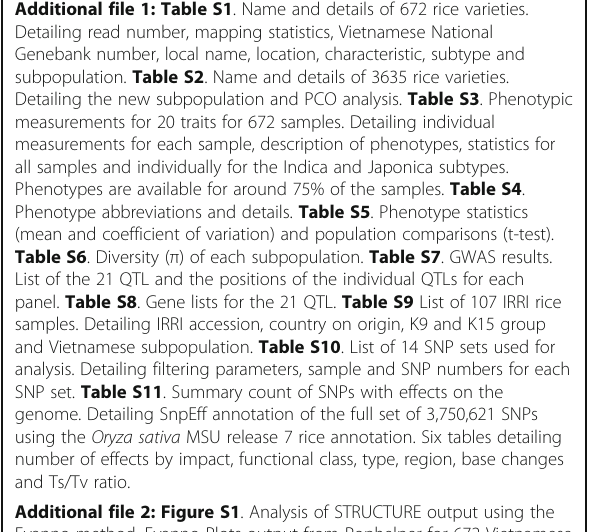
Additional file 2: Figure S1 . Analysis of STRUCTURE output using the Evanno method. Evanno Plots output from Pophelper for 672 Vietnamese samples, 426 Indica samples and 211 Japonica samples. Figure S2 . Mapping rate (%properly paired) for Japonica and Indica subpopulations. Figure S3 . Principal coordinate analysis (PCO) of the 3635 Asian cultivated rice genomes. Plots are coloured by the subpopulations a K9_new, b K15_new. The first component represents the separation between the Indica and Japonica lines. The second components show the separation of cAus and to a lesser extent cBas while the third and fourth components represent the separation within Japonica and Indica respectively. Note for (a) we display the first 3 components and for (b) we display components 1, 2 and 4. Figure S4 . Comparison between K15_3KRGP, K15_new and Vietnamese subpopulations. a Comparison between K15_3KRGP and K15_new using 3023 samples. b Comparison between K15_new and Vietnamese subpopulations using 668 samples (overlap of 56 samples from Vietnam with a). c Percentage of K15_new subpopulations from Vietnam. Arrow are shown for subpopulations which consist of >50% of samples from Vietnam. Diagram generated using http://sankeymatic.com/. Figure S5 . PCO analysis of 1605 Indica samples. Omitting the samples classified as XI-adm and Ind-adm outside Vietnam for clarity. Plot coloured by a K15_3KRGP, b K15_new including Vietnamese samples, c Five Vietnamese Indica subpopulations. The ellip- ses show the 95% confidence interval. X= PC1, Y=PC4, Z = PC5. Figure generated using rgl https://r-forge.r-project.org/projects/rgl/. Figure S6 . PCO analysis of 982 Japonica samples. Omitting the samples classified as GJ-adm and Jap-adm outside Vietnam for clarity. Plot coloured by a K15_3KRGP, b K15_new including Vietnamese samples, c Four Vietnam- ese Japonica subpopulations. The ellipses show the 95% confidence inter- val. X= PC3, Y=PC4, Z =PC5. Figure generated using rgl https://r-forge.r- project.org/projects/rgl/. Figure S7 . Admixture components of the Indica I3, I4 and I5 subpopulations. Figure S8 . PCA analysis of Indica and Japon- ica Vietnamese subpopulations including 51 genotypes from outside Vietnam. a PCA analysis of 445 accessions using the top two components to separate the five Indica subpopulations. The ellipses show the 95% confidence interval. b PCA analysis of 233 accessions using the top two components to separate the four Japonica subpopulations. The ellipses show the 95% confidence interval. Figure S9 . Correlation between